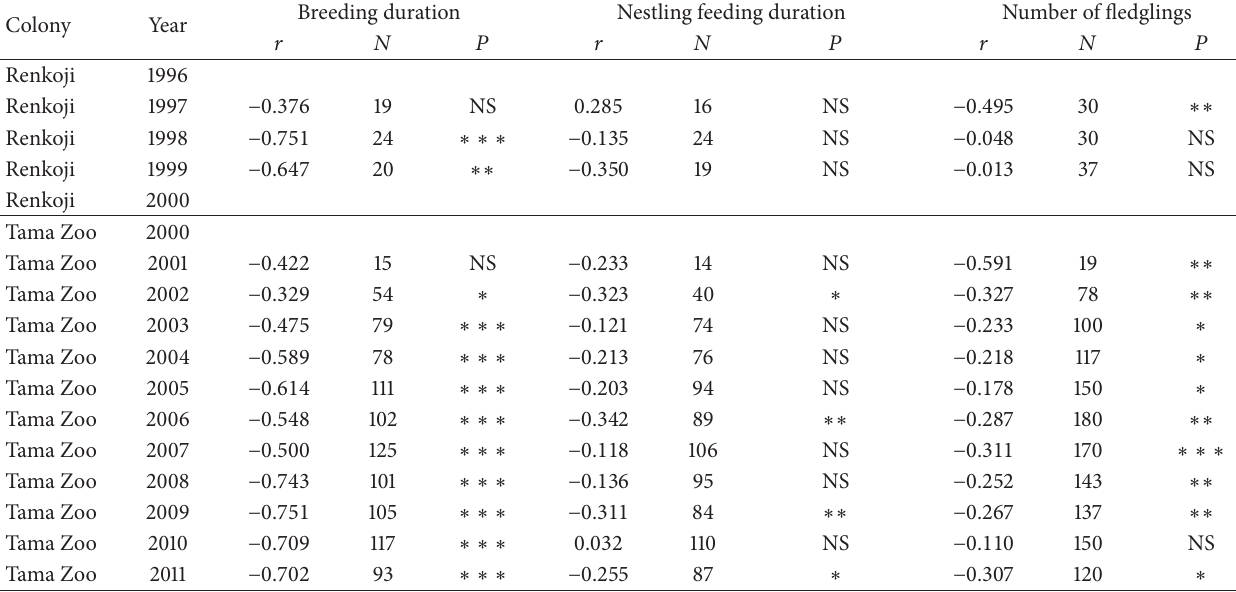
Table2:Correlationcoefficientsbetweenthedateofstartingbreedingandthebreedingduration,thenestlingfeedingduration,orthenumber of fledglings in each